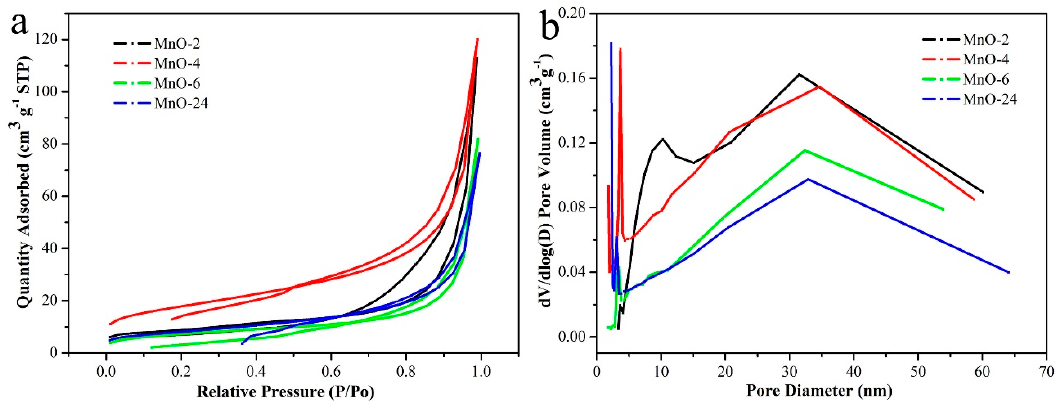
Figure 1. XRD patterns of the as-prepared MnO nanomixtures samples.